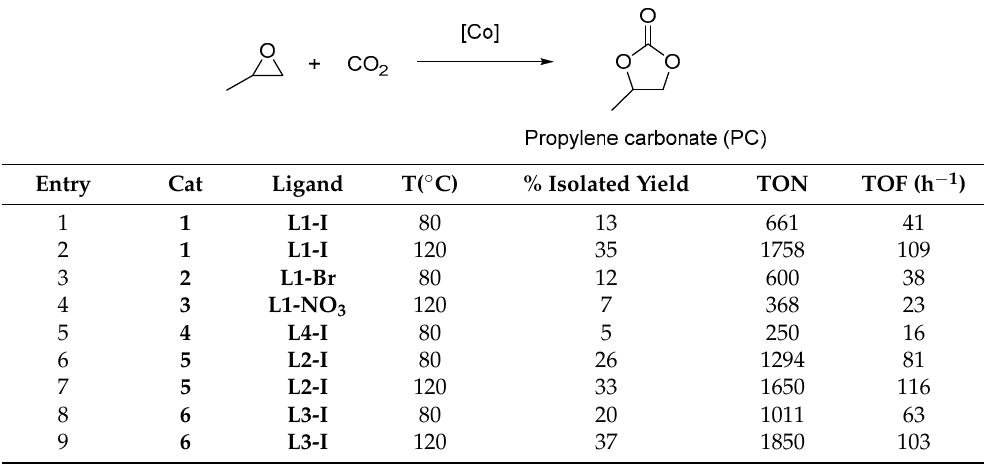
Table 3. Catalytic coupling reactions of propylene oxide and CO 2 with Co(ONONu) complexes a .